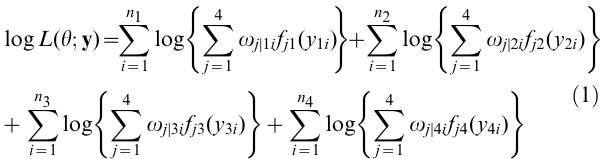
No. Mating Type F 2